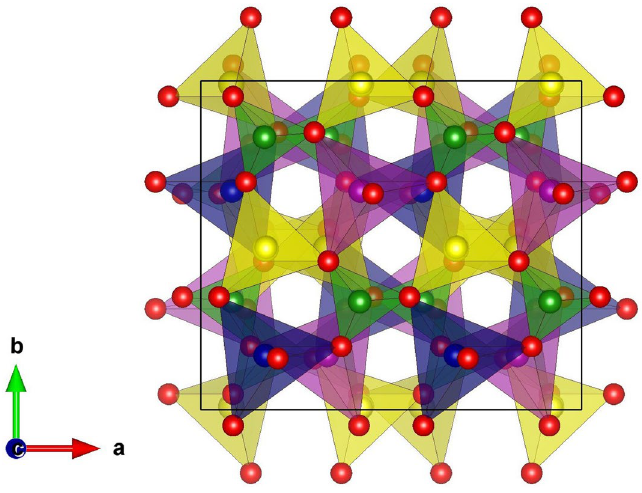
Figure 1. Crystal structure of LiMn 1 − x Co x BO 3 materials at x = 0.5 , where the yellow color represents Li, blue Mn, lilac Co, green B and red O atoms, respectively. The figure was built up using VESTA software.